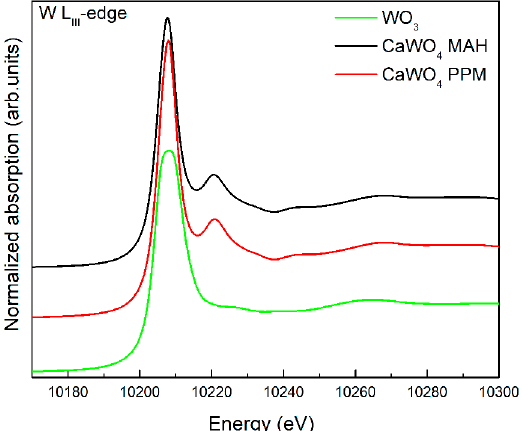
-edge of CaWO III